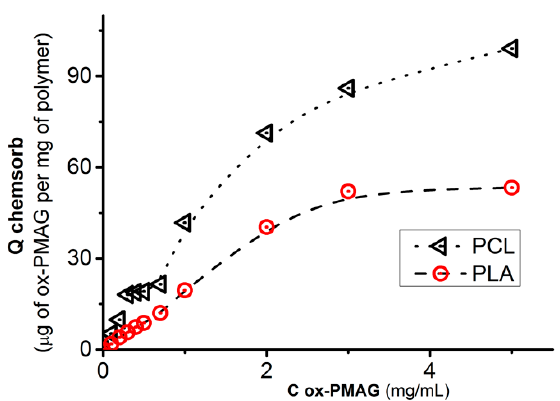
Figure 4. Isotherms of ox-PMAG adsorption on the surface of aminated PLA and PCL. Conditions: 0.01 M sodium borate buffer solution, pH 8.5, 25 °C, 300 rpm.